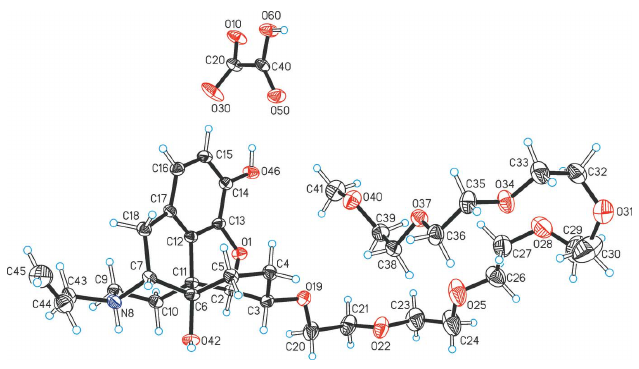
Figure 1 The asymmetric unit of (I), with displacement ellipsoids drawn at the 50% probability level and H atoms drawn as spheres of arbitrary size.